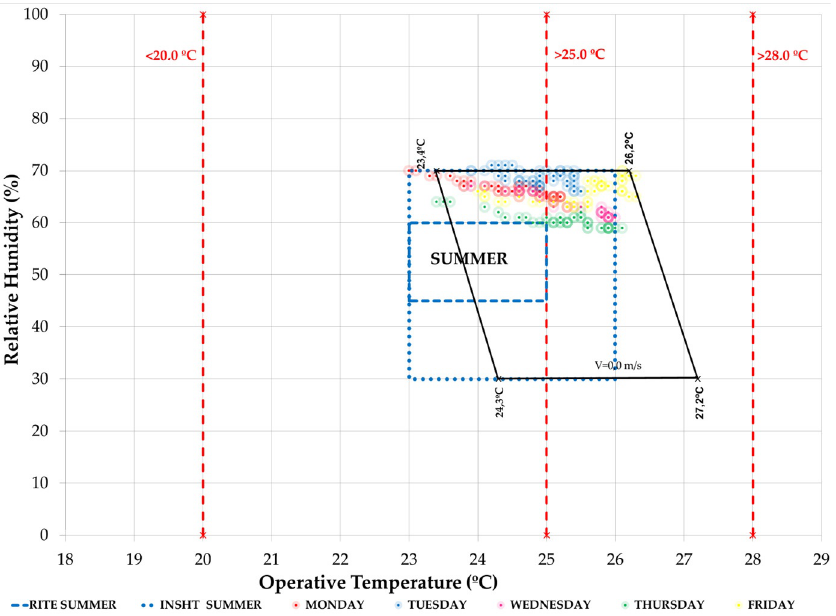
Figure 23. Hygrothermal comfort in the administration office during the week of 2022-07-11 to 2022- 07-15 (Phase III). Source: authors. (Phase III). Source: